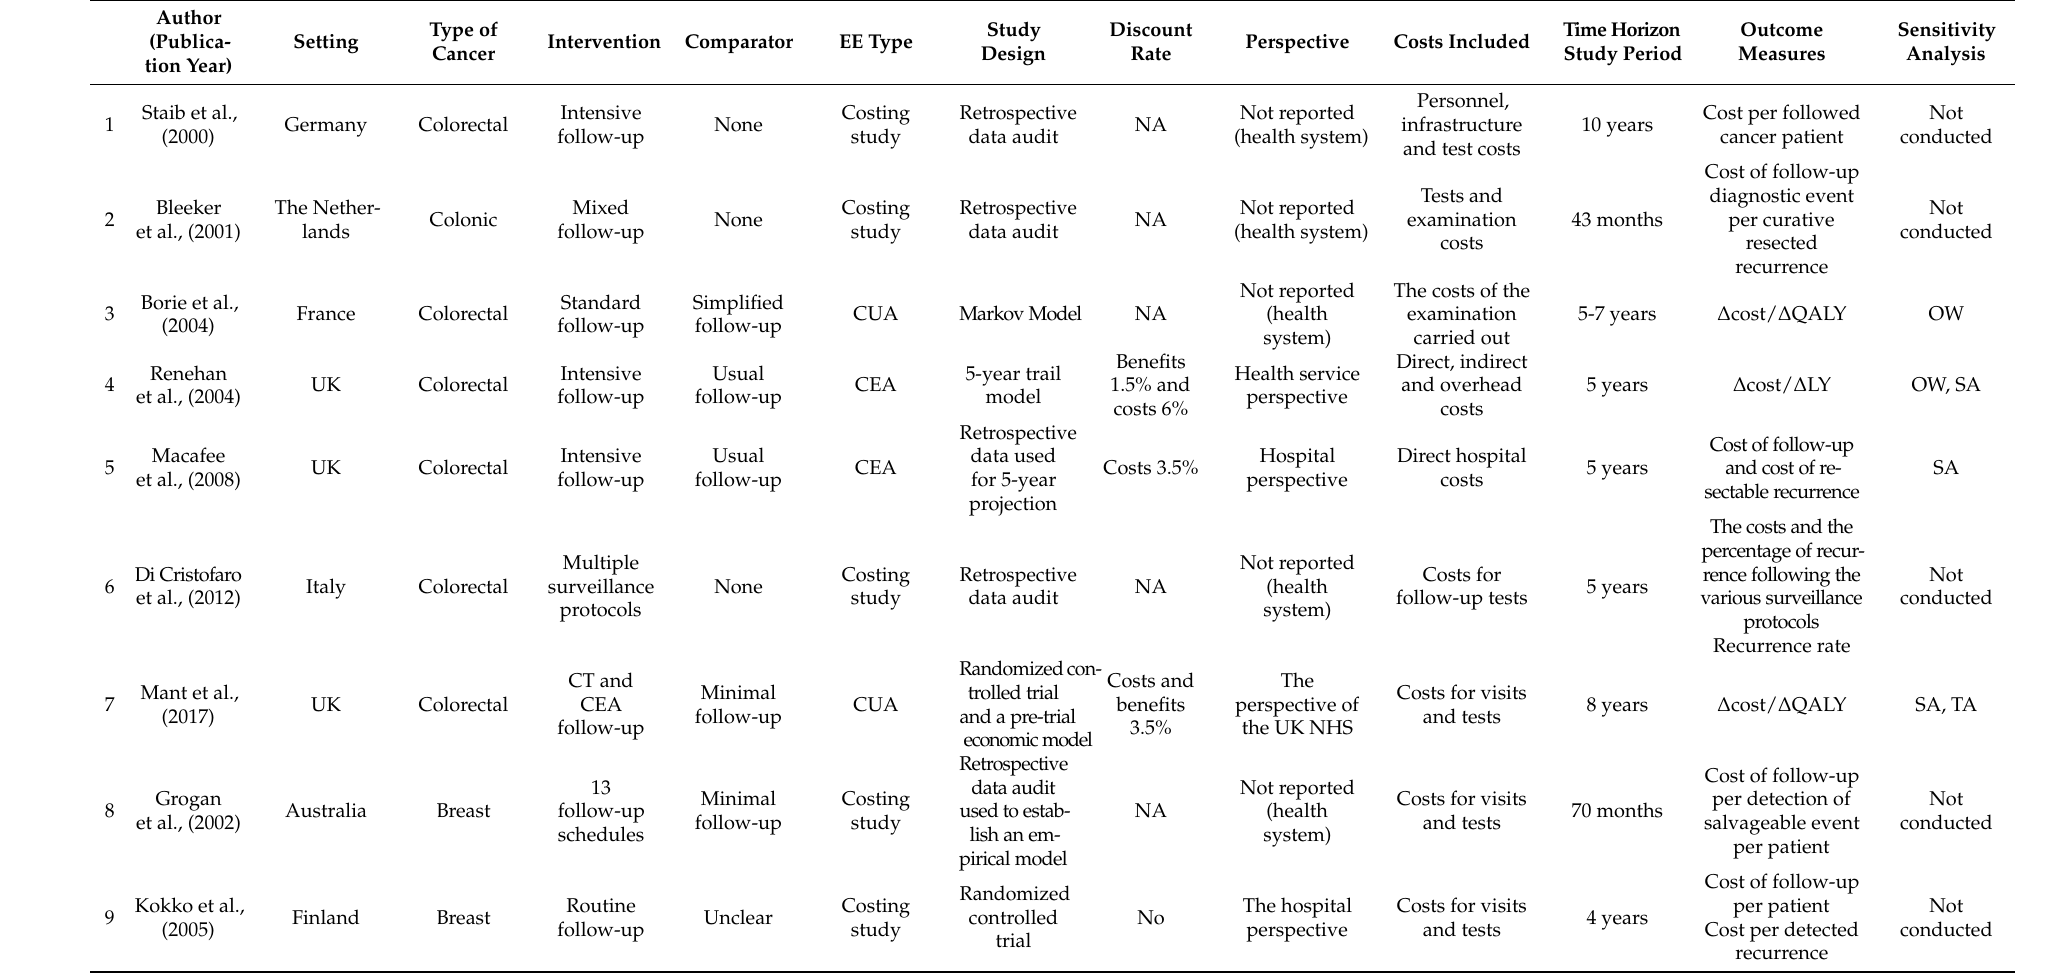
Table A5. Characteristics of included